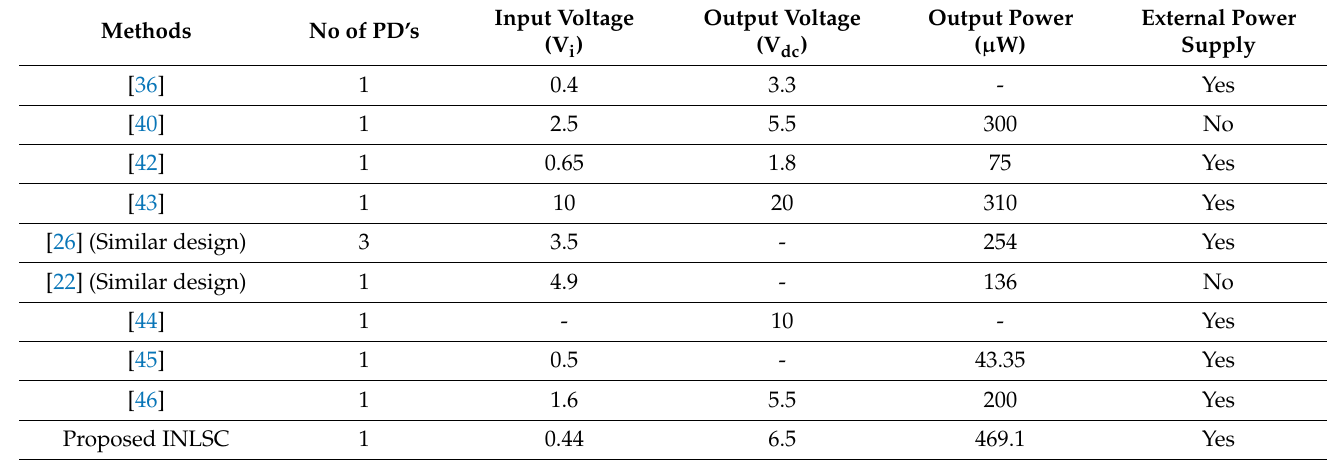
Table 2. Comparison of the output of numerous circuits available in the